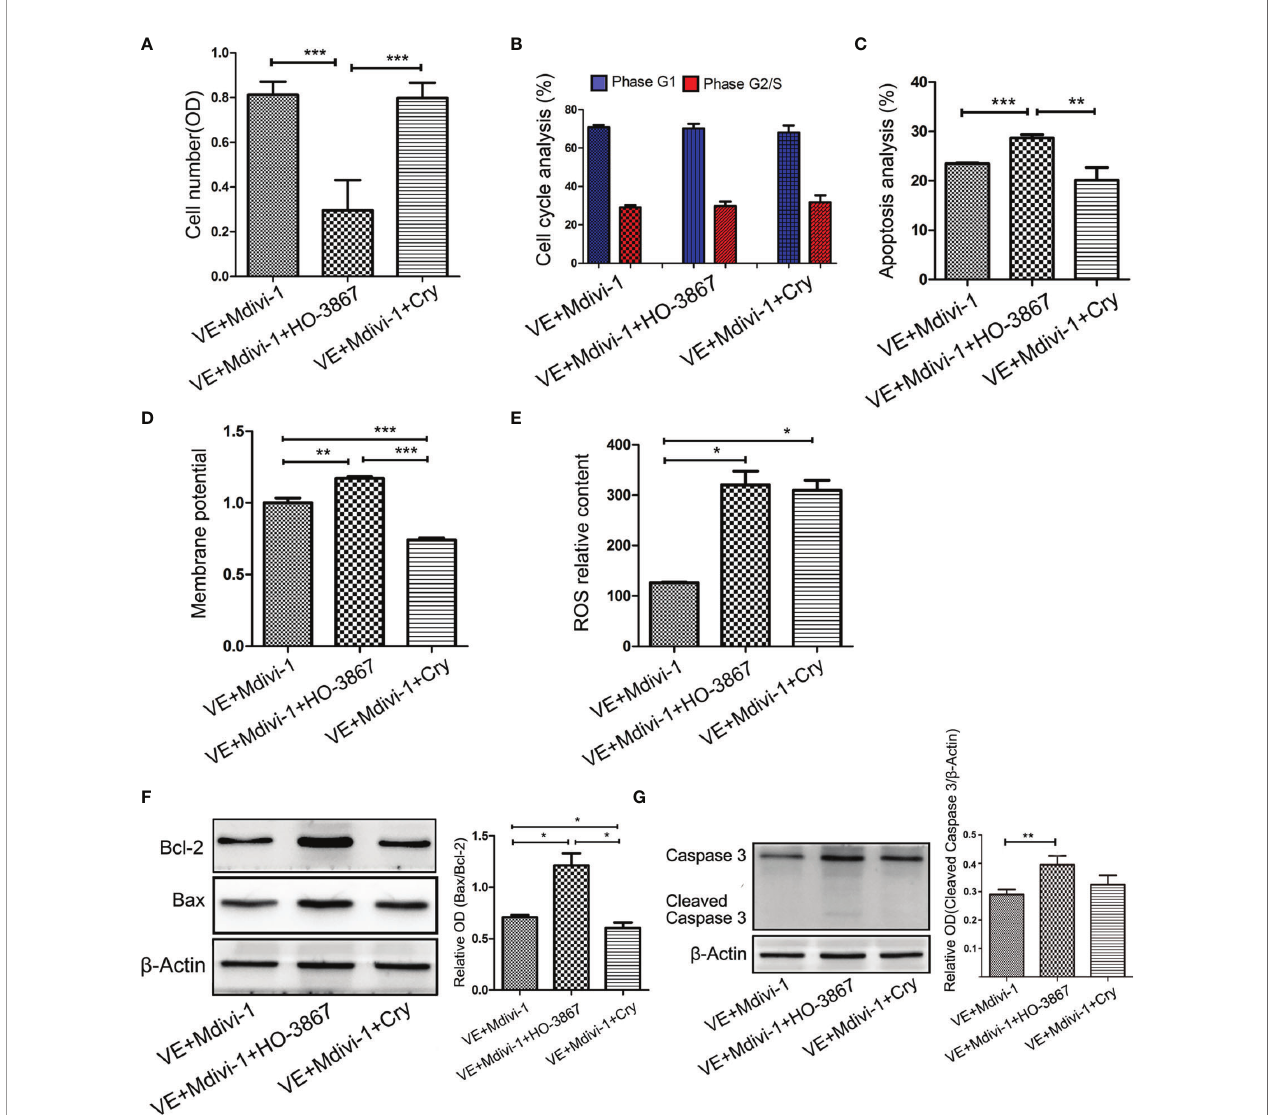
FIGURE 5 | Inhibition of STAT3 reversed the Drp1 regulating pro-proliferation of GH3 cells. (A) The number of GH3 cells in three groups (VE+Mdivi-1, VE+Mdivi-1 +HO-3867, VE+Mdivi-1+Cry) at 48 h were assessed by CCK-8 assay (n = 3). (B) Cell cycle at 48 h were analyzed by fl ow cytometry (n = 3). (C) Cell apoptosis at 48 h were analyzed by fl ow cytometry (n = 3). (D) Mitochondrial membrane potential of three GH3 cell groups were detected by fl ow cytometry using Rhodamine123 at 48 h (n = 3). (E) Reactive oxygen species (ROS) were detected by fl ow cytometry using DCF-DA fl uorescence at 48 h (n = 3). (F) The expression of Bcl-2 and Bax proteins were detected by western blotting (n = 3) (left panel). Statistical analysis of the western blotting results (right panel). (G) The expression of cleaved caspase-3 protein was detected by western blotting (n = 3) (left panel). Statistical analysis of the western blotting results (right panel). *P < 0.05, **P < 0.01, ***P < 0.001. Data were expressed as mean ±